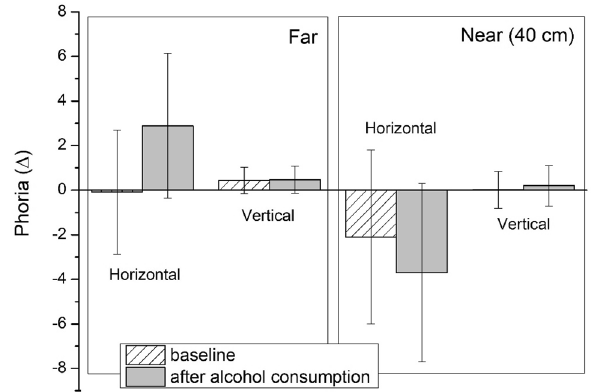
Figure 2. Mean values for distance and near phorias (horizontal and vertical) at baseline and after alcohol consumption (BrAC = 0.40 mg/l). Error bars show standard deviations.